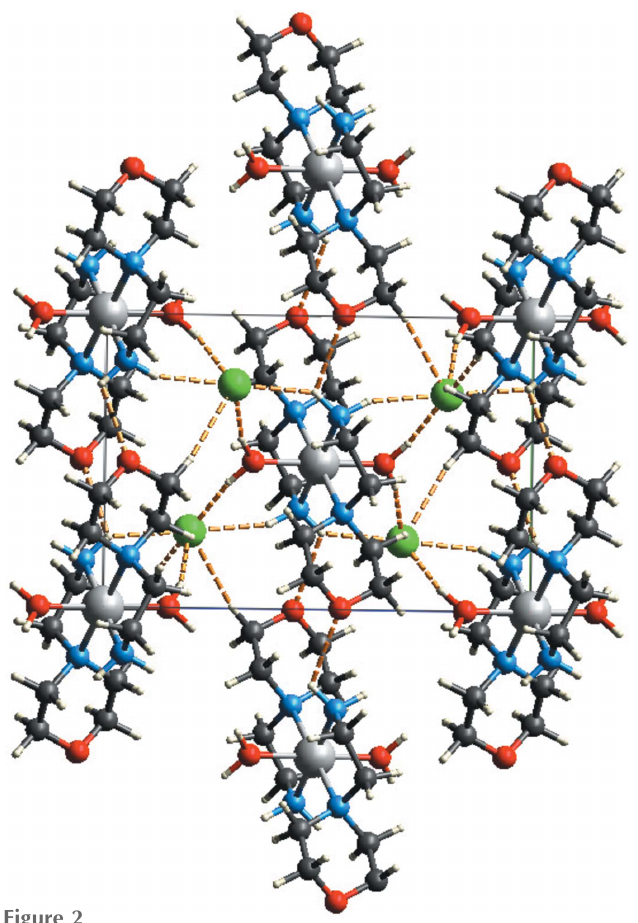
Figure 2 Supramolecular interactions (dotted lines) in the title